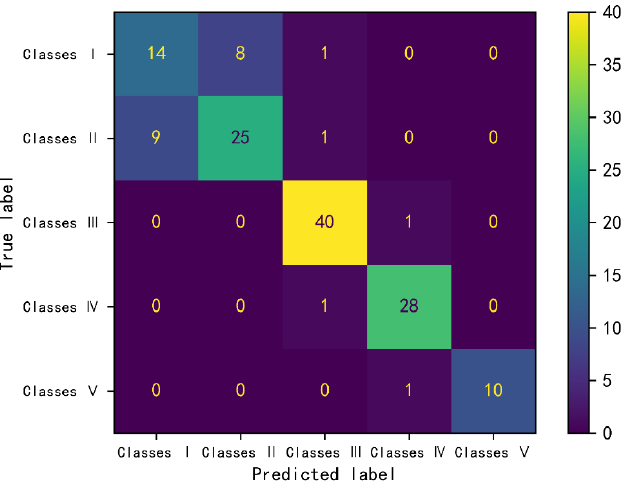
Figure 11. Confusion matrix using gradient boosting of significant features under K-fold cross-validation strategy.